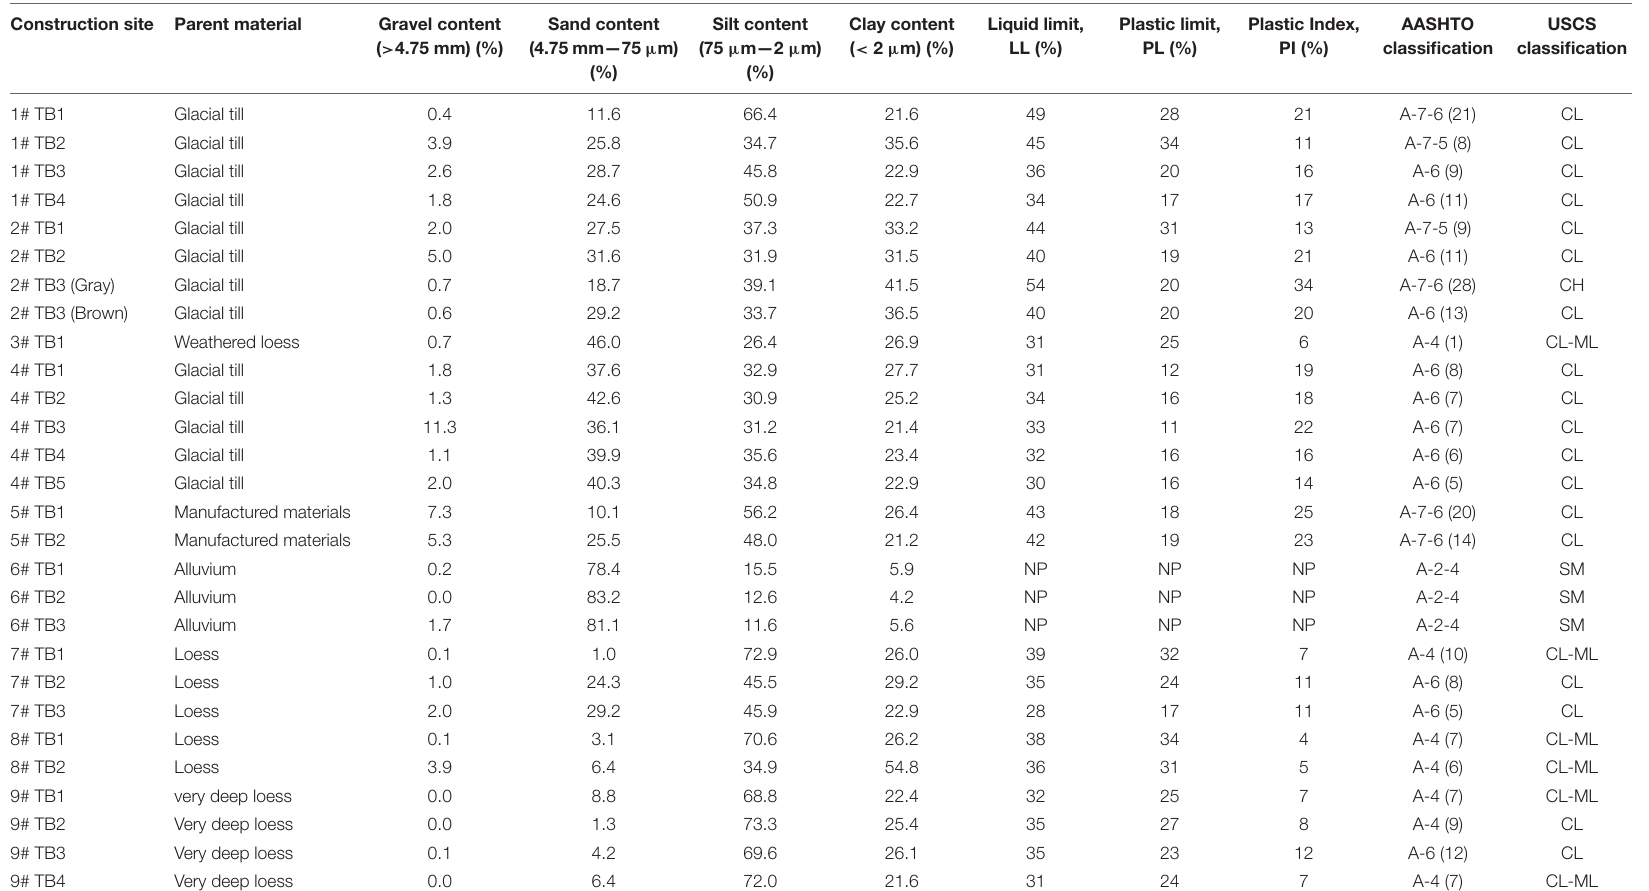
TABLE 1 | Soil index properties of the granular and cohesive subgrade materials tested in this study. Construction site Parent